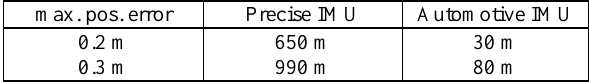
Table 1. Maximum distance without landmark update with a maximum positioning error of 0.2 m and 0.3 m.